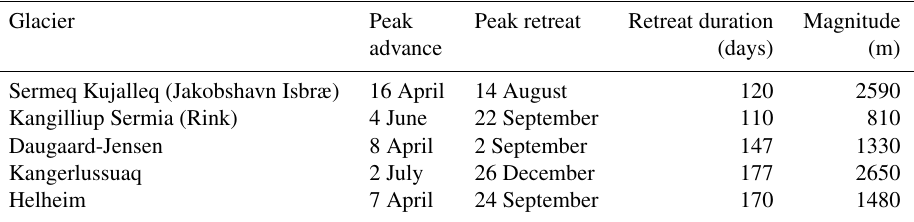
Table 4. Timing and magnitude of terminus-position seasonality for several individual glaciers for comparison with previous studies. All reported values are medians for the given glacier. Glacier Peak Peak retreat Retreat duration Magnitude advance (days)